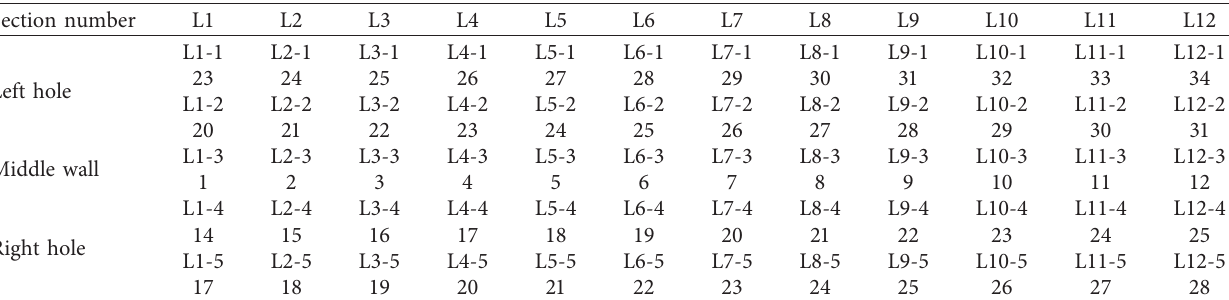
Table 4: Excavation sequence of excavation scheme III.